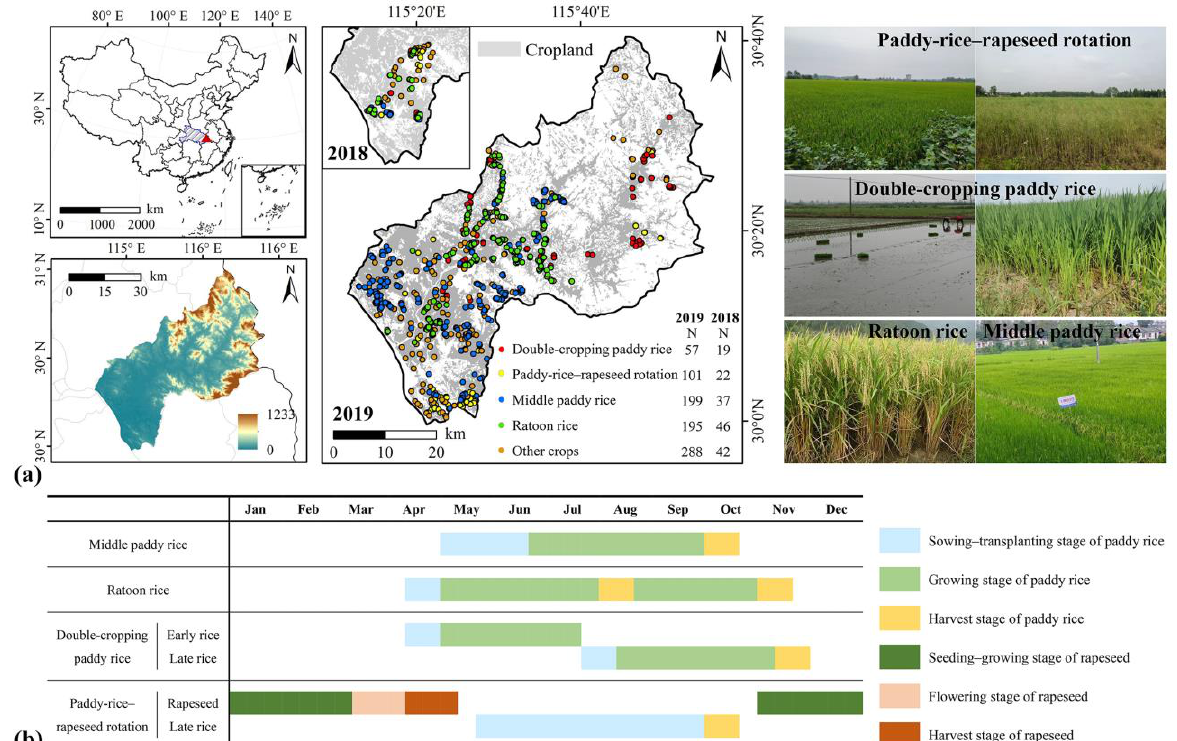
Figure 1. ( a ) Location and DEM of Qichun county in Hubei Province, China. The cropland data were extracted from the GlobeLand30 product in 2020. The number (N) and the spatial distribution of field samples for different crop types obtained in 2019 and 2018 were also displayed. The example photos of paddy-rice – rapeseed rotation, double-cropping paddy rice, ratoon rice, and middle paddy rice are shown in the right panel. ( b ) The crop calendars of four PRCPs in the study area. Table 1. Band parameters of the HLS L30 and S30 surface reflectance